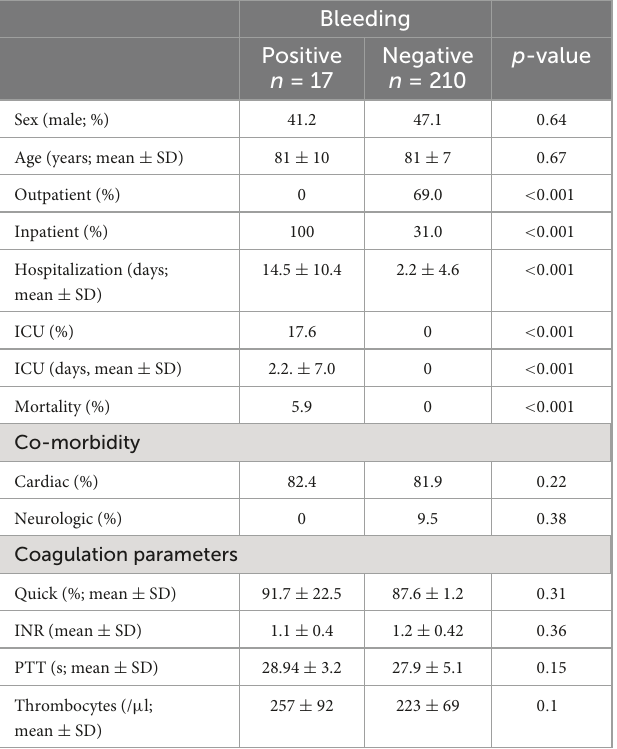
( n = 162) patients without bleeding. A total of 34 trauma patients were on new oral anticoagulants (NOAC), of whom 8.8% ( n = 3) presented with intracerebral hemorrhage and 91.2% ( n = 31) did not ( p = 0.748). Five patients took coumarins (Vitamin K antagonists, phenprocoumon/warfarin). Another 29 of the 227 patients were on other platelet aggregation inhibitor than ASA [(PAI), like clopidogrel or ticagrelor] but none of them showed higher risk for post- traumatic hemorrhage ( p > 0.1). In total, 9 of 227 (4%) patients were taking low-molecular-weight heparin (LMWH). Among them intracerebral hemorrhage was significantly more frequent (23.5 vs. 2.4%, p < 0.001).